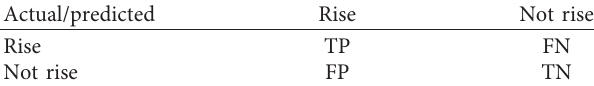
Table 3: Confusion matrix of upward movement.